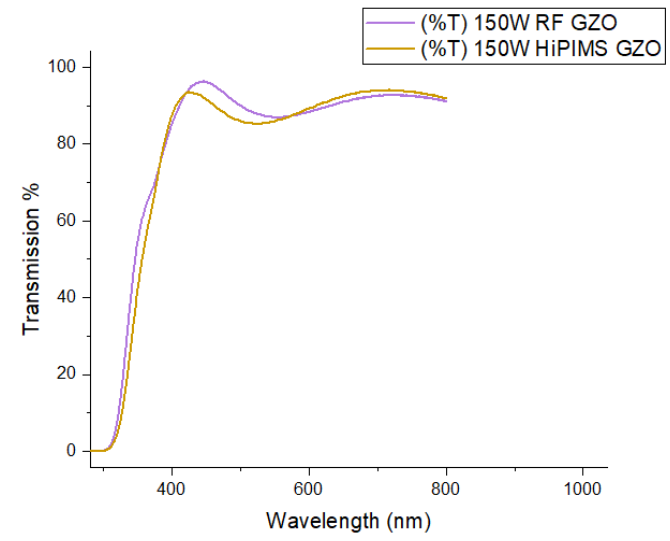
Figure 6. Graph comparison of RF and HiPIMS transmission.